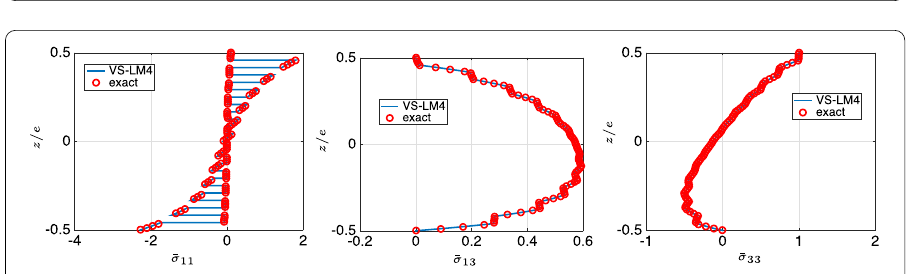
Fig. 7 Distribution of ¯ σ 11 (left), ¯ σ 13 (middle) and ¯ σ 33 (right) along the thickness—S=4–24 layers— φ = π/